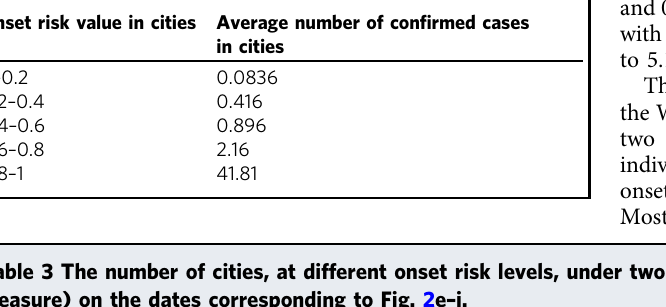
Table 2 The relationship between the predicted risk of COVID-19 symptom onset shown by the extended WKDE model and the average number of con fi rmed cases in